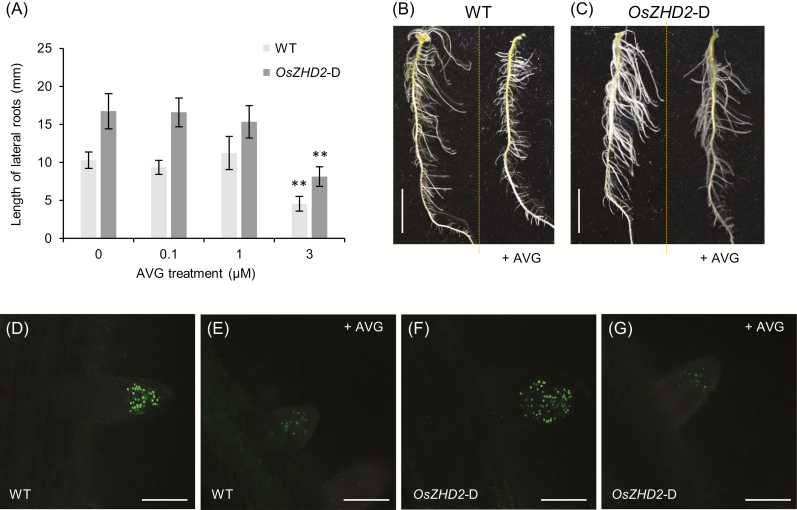
Effect of the ethylene biosynthesis inhibitor AVG on lateral root development. Seedlings at 3 DAG were transferred to AVG-containing medium and grown for an additional 3 d. (A) Lateral root length. The length of lateral roots was measured from the top 1 cm region of seminal roots. n>40. Statistical significance is indicated by * (P<0.05) and ** (P<0.01). (B and C) Phenotypes of the seminal roots of WT (B) and OsZHD2-D (C) seedlings grown on MS medium without (left) and with (right) 3 µM AVG. Scale bar=1 cm. (D–G) Visualization of S-phase entry cells at lateral root tips. Seedlings of the WT (D and E) and OsZHD2-D (F and G) grown on MS medium without (D and F) or with 3 µM AVG (E and G) were incubated with 10 µM EdU for 2 h before visualization. Scale bars=100 µm.